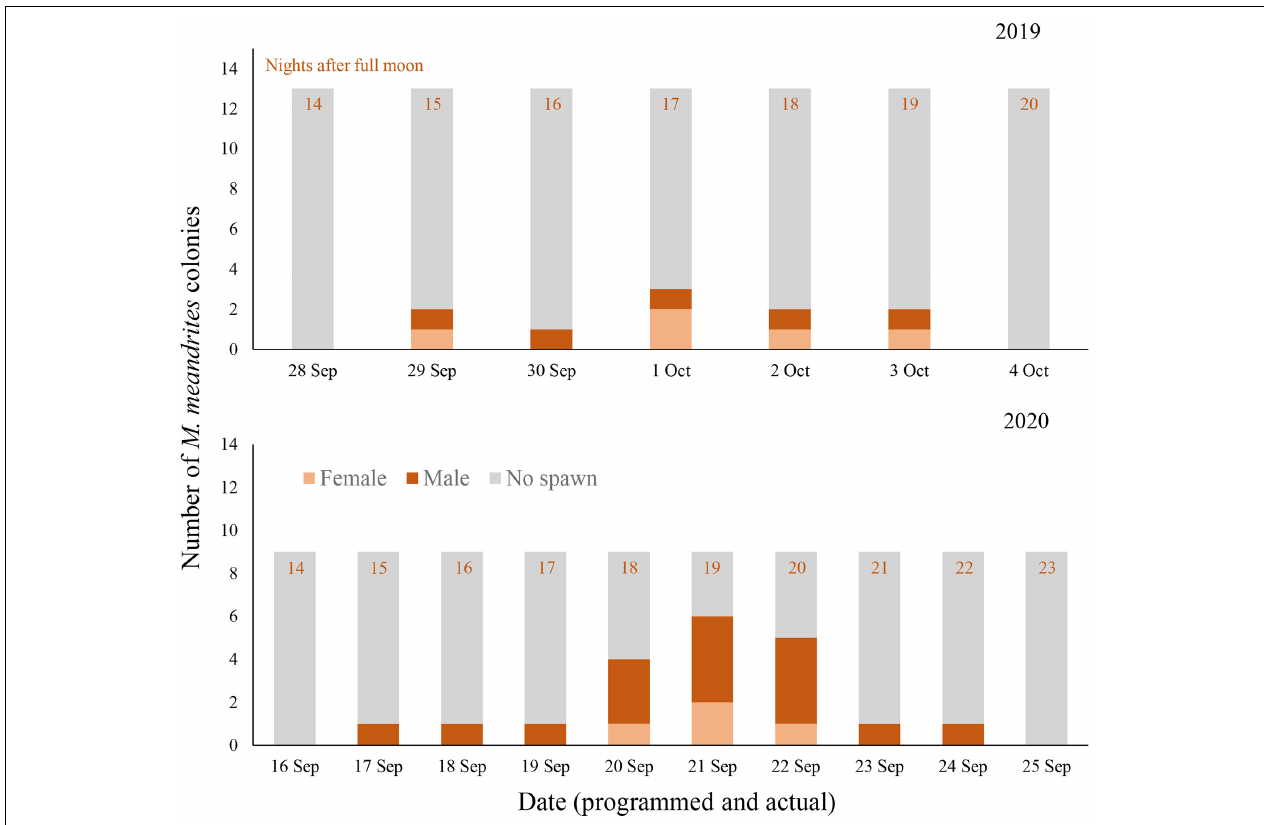
FIGURE 4 | Daily spawning observations of M. meandrites colonies in controlled systems during 2019 (top) and 2020 (bottom). Annual photoperiod, irradiance, lunar, and temperature cycles in the fully enclosed systems were programmed to match those in the Florida Keys. Programmed and actual dates align and are noted on the x